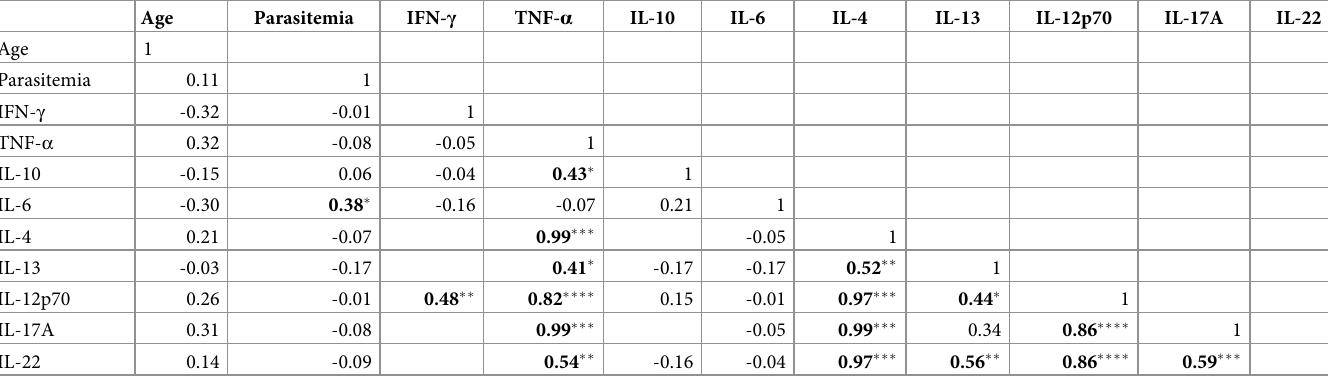
Table 2. Multivariate bilateral analysis between cytokines, age and parasitemia in asymptomatic